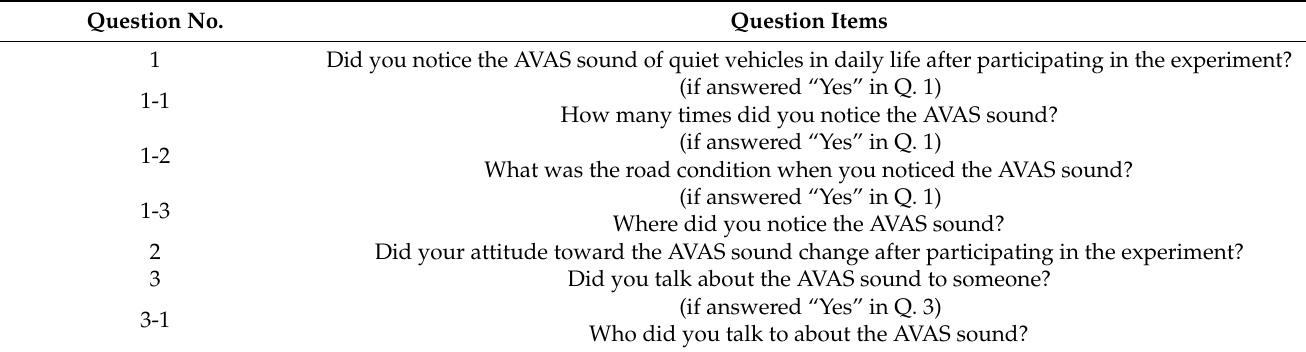
Table 1. Question items used in the follow-up